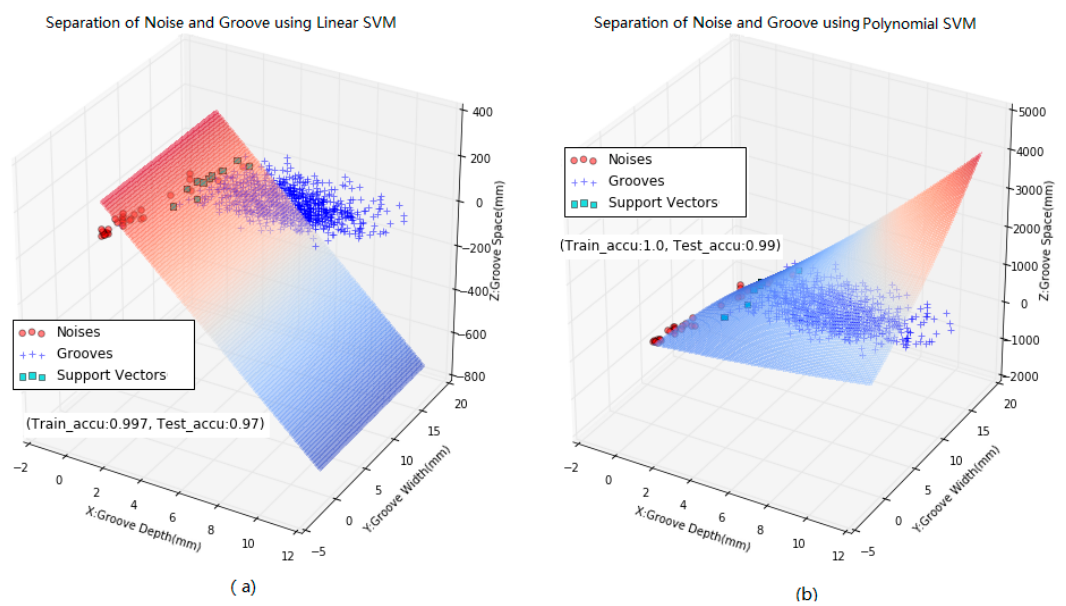
Figure 10. Comparison of separation of noises and true grooves with three feature vectors: ( a ) linear model; ( b ) polynomial model.